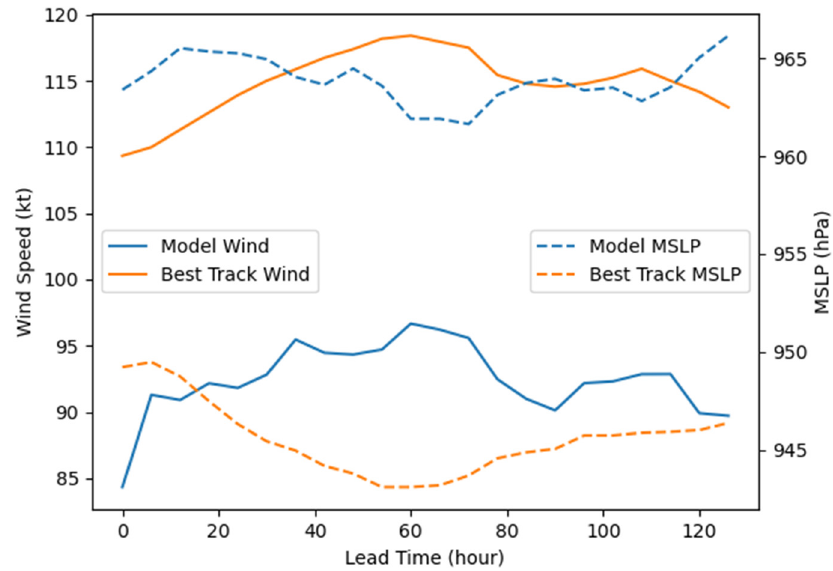
Figure 5. Observed (brown) and model predicted (blue) minimum sea level pressure (dashed line) and maximum wind speed (solid line) of hurricane Dorian (2019) in its mature stage, as a function of the forecast lead